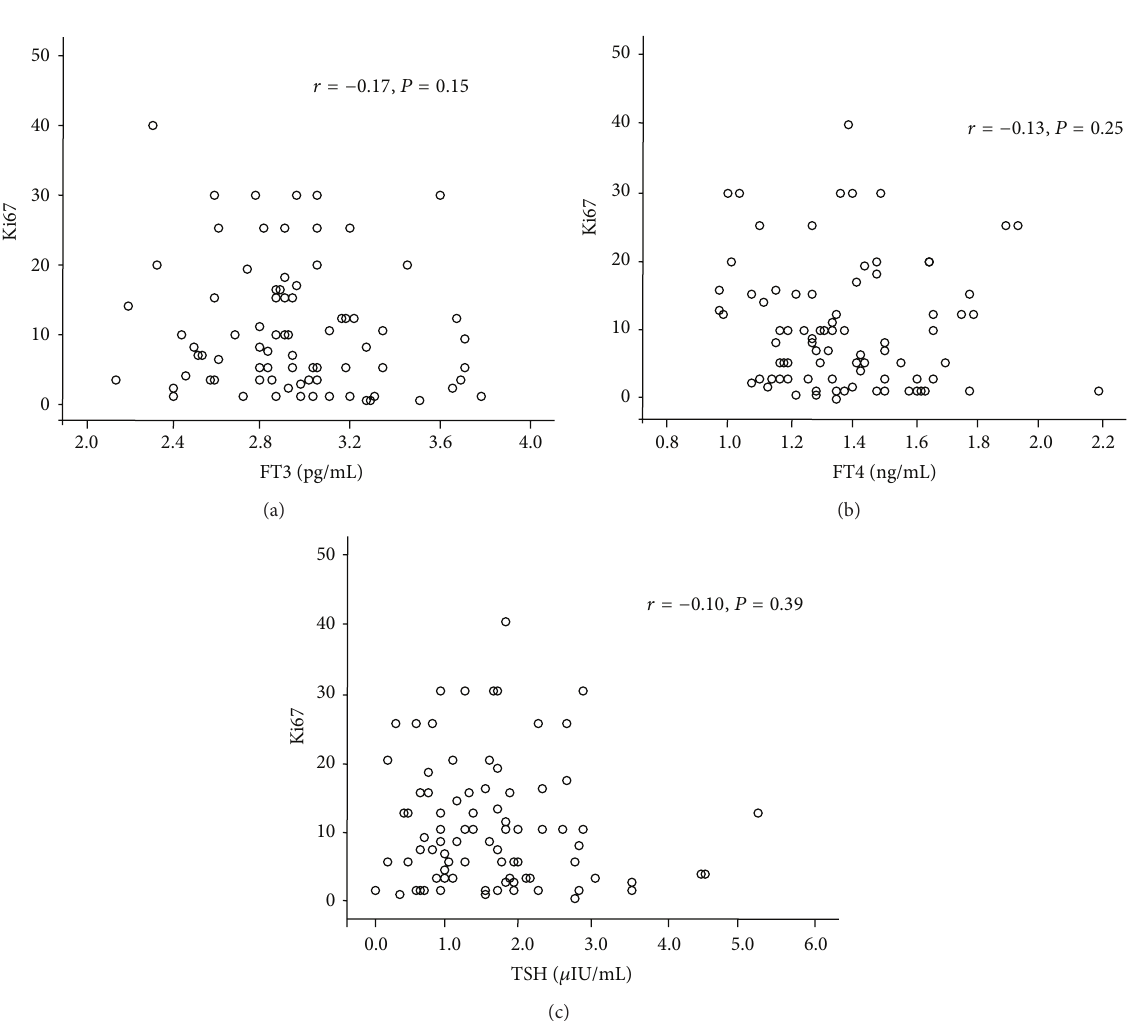
Figure 1: Scatterplots showing no correlation between proliferation index Ki67 and (a) FT3, (b) FT4, and (c) TSH in breast cancer patients including both HER2( − ) and HER2(+)